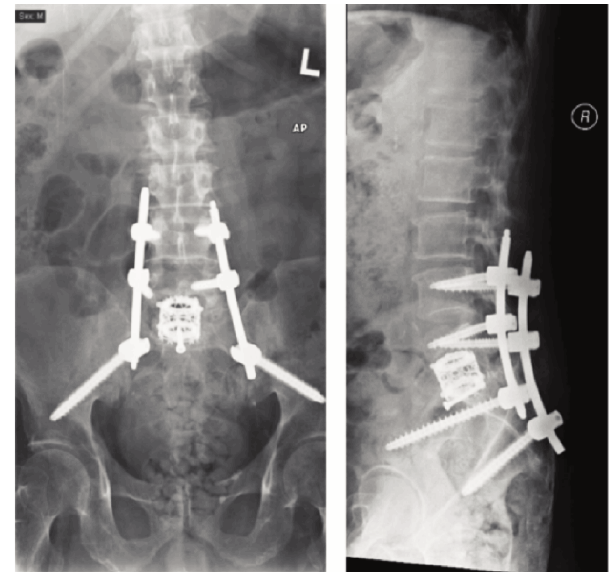
Post-operative radiographs of anteriorposterior and lateral views of lumbo-sacral Fig. 3: